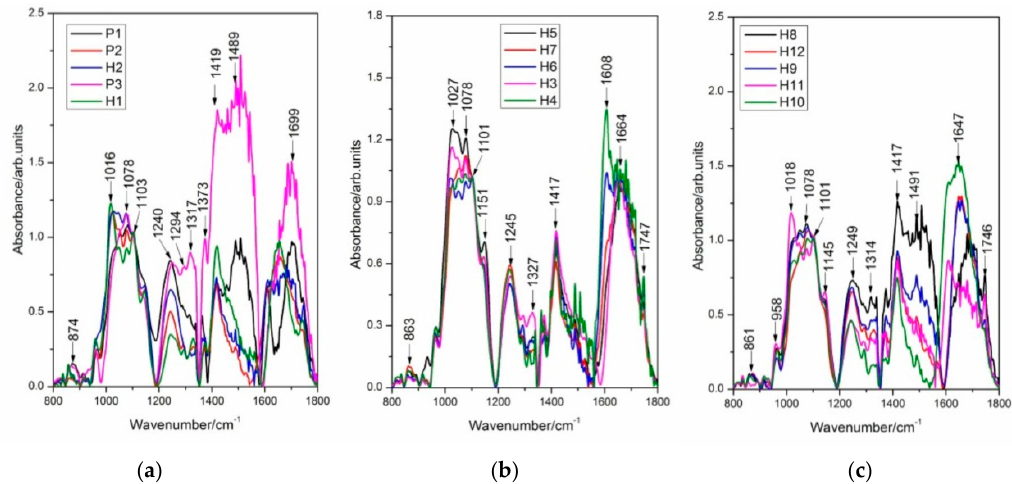
Figure 5. Intensity changes in FT-IR absorbance spectra of DNA extracted from different Streptocarpus parents and hybrids, as labeled in the figure: Spectra were scaled to have the same intensity in the 1101 cm − 1 ( υ s PO 2- ) band. Profiles are presented in the wavenumber range 800–1800 cm − 1 .